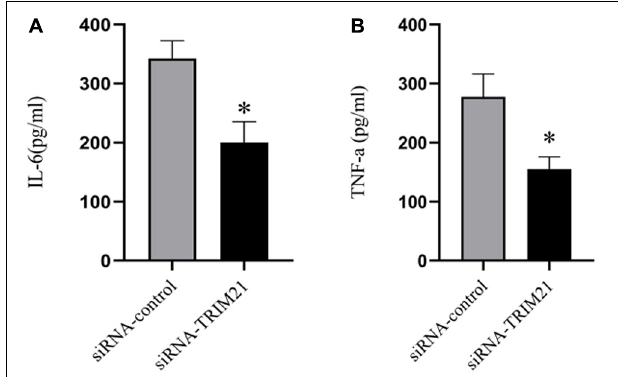
FIGURE 4 | Silencing TRIM21 reduces pro-inflammatory cytokines in HSV epithelial keratitis. ELISA measured the protein expression levels of corneal IL-6 (A) and TNF-a (B) . n = 3 per group. Data are shown as mean ± SD of three independent experiments. ∗ P <